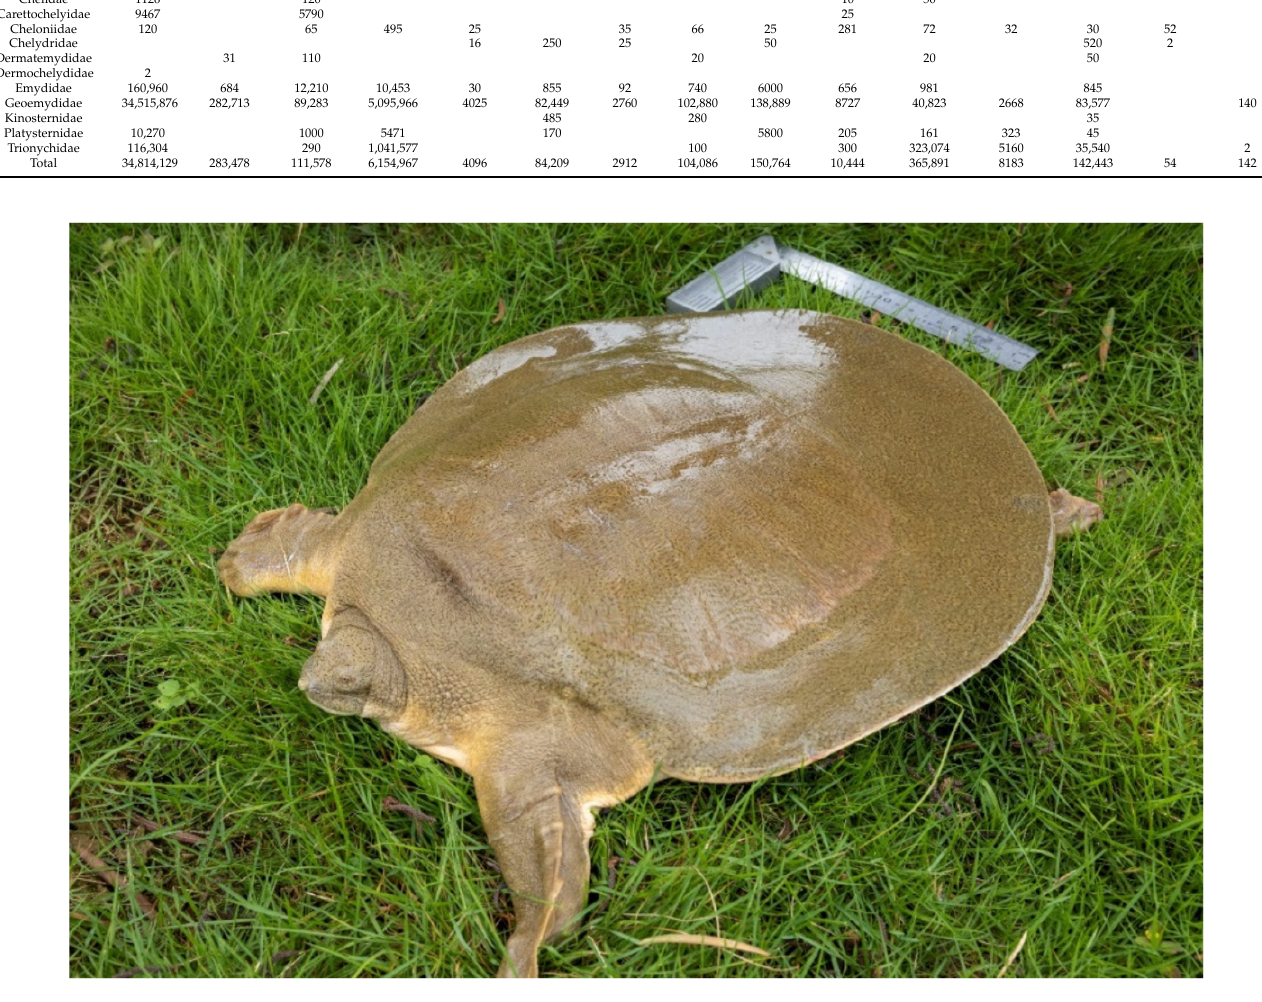
Figure 2. Artificially bred 5-year-old Asian giant softshell turtle. There are a number of sea turtles held in parks for the public to view. The most endangered sea turtle is the leatherback turtle, Dermochelys coriacea , of which only two individuals were